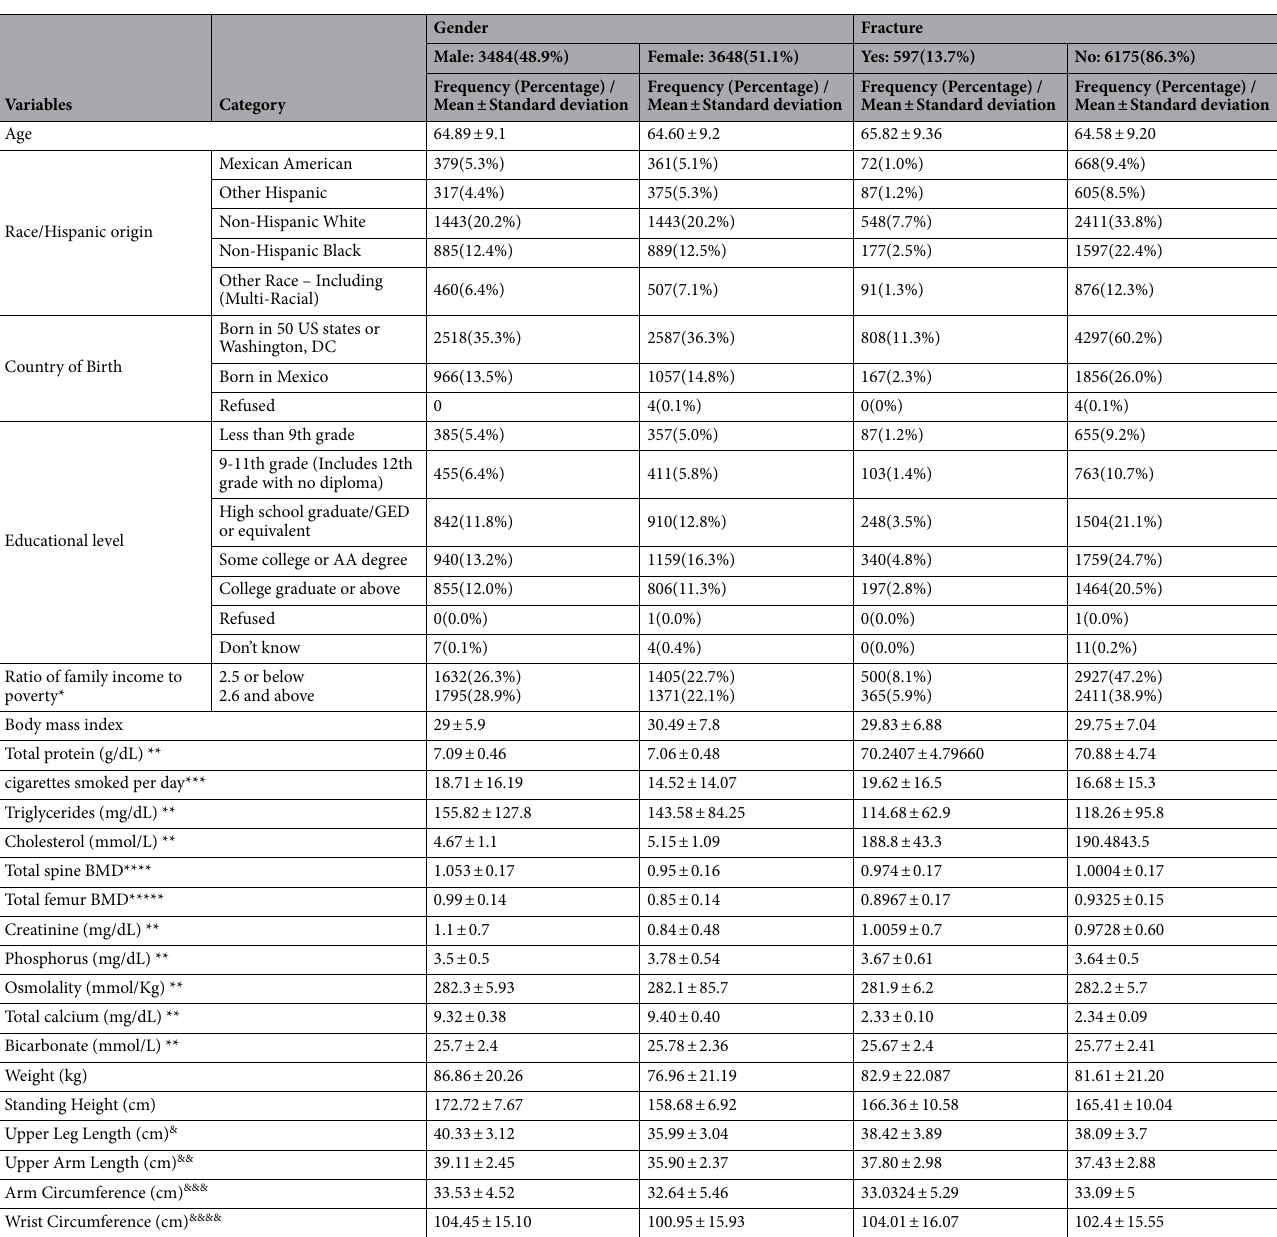
Table 1. Baseline characteristics of the study sample. *Missing data: 13%, **Missing data: 6.3%, ***Missing data: 68.8%, ****Missing data: 53.2%, *****Missing data: 15.9%, &Missing data: 5.8%, &&Missing data: